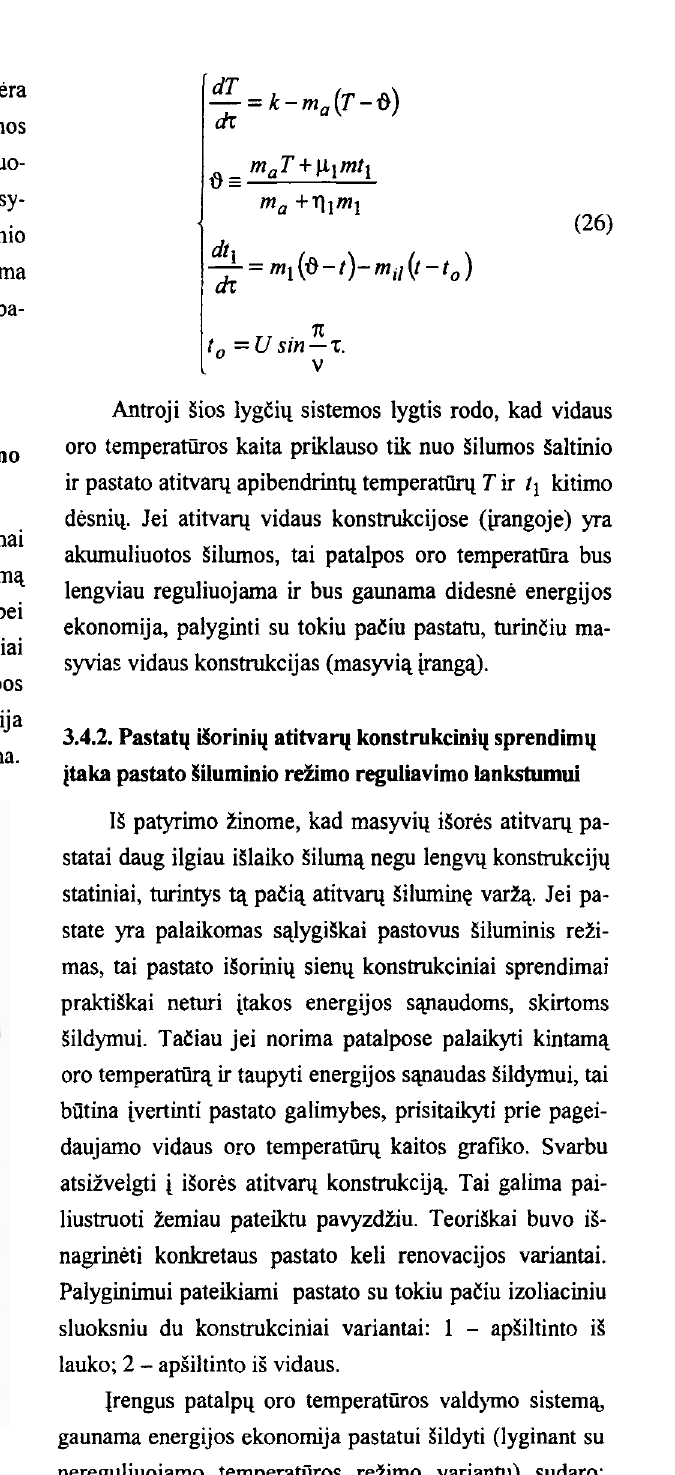
Fig 2. Position of insulating layer for massive external wall Panagrinekime ribini atveji, kai vidaus